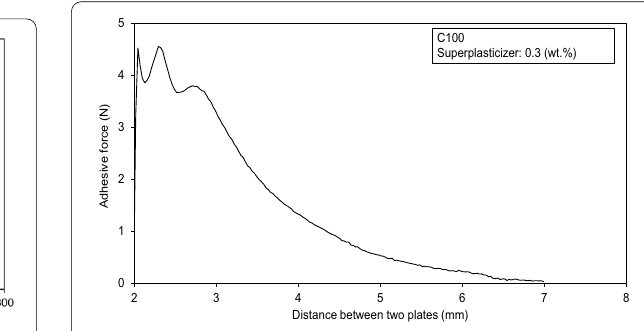
Fig. 3 Shearing protocol for the rheology test. Fig. 4 Example of adhesive force